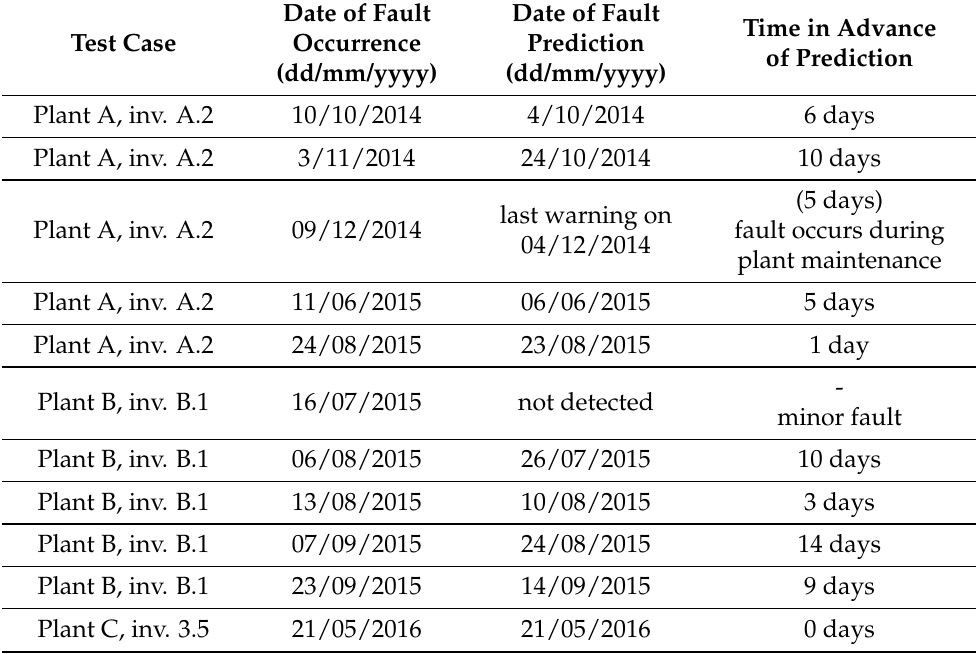
Table 9. Summary of the predictive performance of the proposed